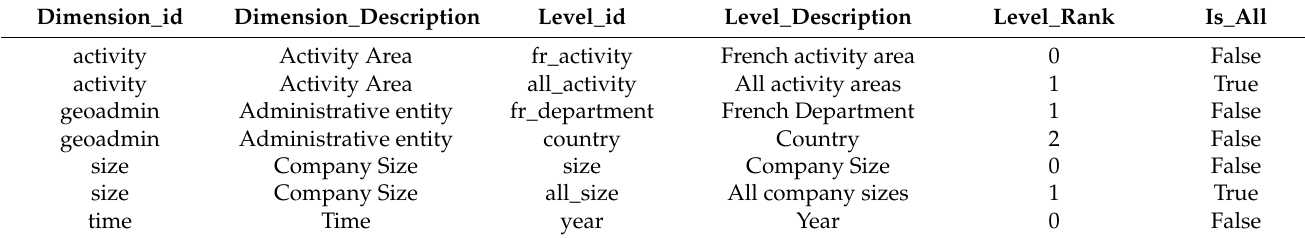
Table 1. Data cube information given query